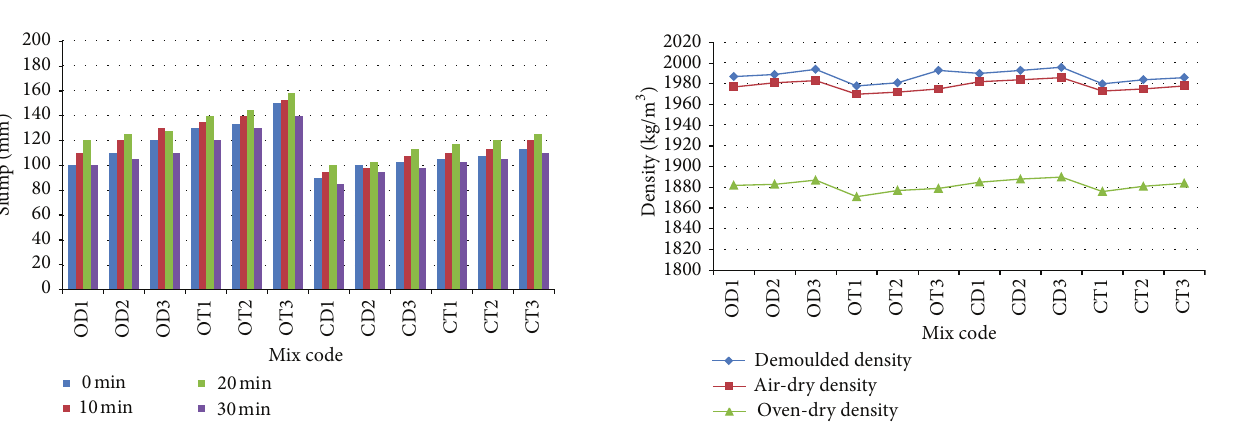
Figure 7: Effect of OPS species (original and crushed) and age categories on workability.